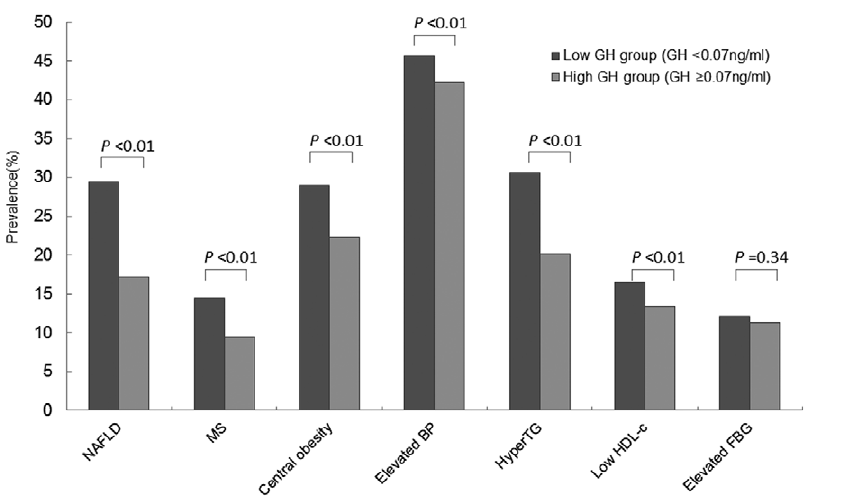
Figure 1. The prevalence of NAFLD and the metabolic syndrome in the subjects with different serum GH levels. The group with higher GH levels showed a lower prevalence of NAFLD, the metabolic syndrome, central obesity, elevated blood pressure, hypertriglyceridemia, and low HDL-C level than the group with lower GH levels. Abbreviations: BP: blood pressure; FBG: fasting blood glucose; GH: growth hormone; HDL-c: high- density lipoprotein cholesterol; MS: metabolic syndrome; NAFLD: nonalcoholic fatty liver disease; TG: